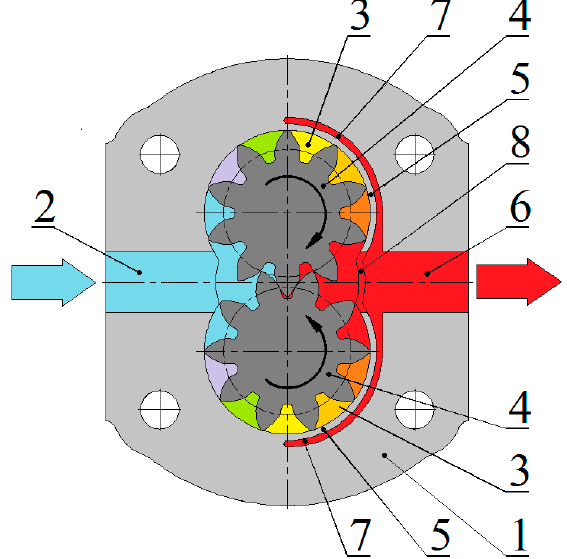
Figure 4. Cross section through internal casing of pump with circumferential backlash compensation, acc. to patent No. PL223649 (patent application No. P.404801 [22]): 1—pump’s inner casing, 2—suction channel, 3—intertooth space, 4—gears, 5—circumferential backlash compensating lip, 6—pressure channel, 7—constant-pressure recess, 8—channel connecting working chamber with pressure channel.